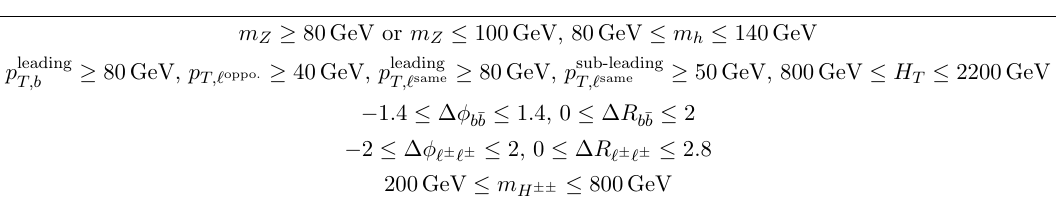
Table 8 . A list of hard cuts for the pp ! H (cid:6)(cid:6) H (cid:7) ! W (cid:6) W (cid:6) hW (cid:7)